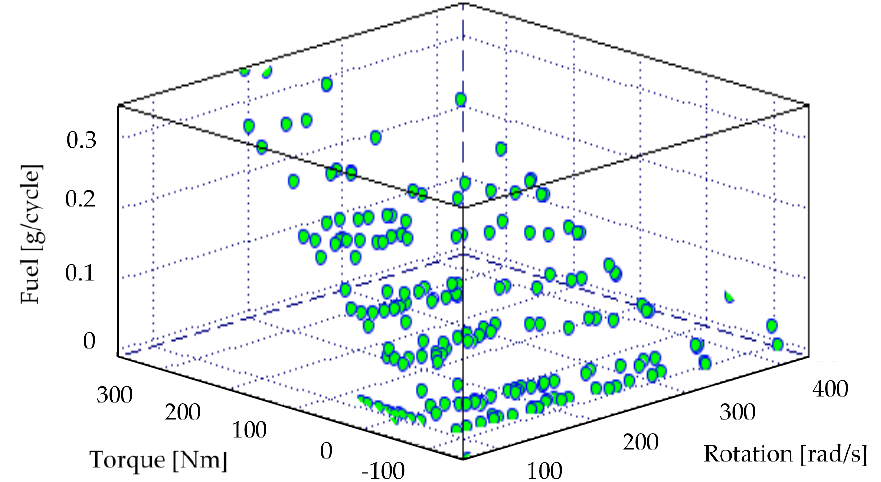
Figure 2. Fuel consumption measurement points for one fuel injection cycle as a function of engine rotational speed and engine torque used for the construction of the neural model.